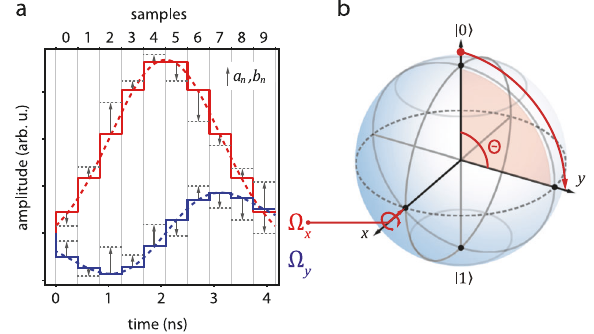
Fig. 1 Control pulse. a The dashed lines show the analytic DRAG pulse, with Ω x in red and Ω y in blue. The solid lines show the same pulse sampled by the AWG. The optimization parameters a n and b n of the piecewise-constant pulse are depicted as modi fi cations of the sampled DRAG pulse by gray arrows and dashed lines. b Ideal Bloch sphere trajectory of the Ω x -pulse. The rotation angle Θ is given by the total area under the pulse.